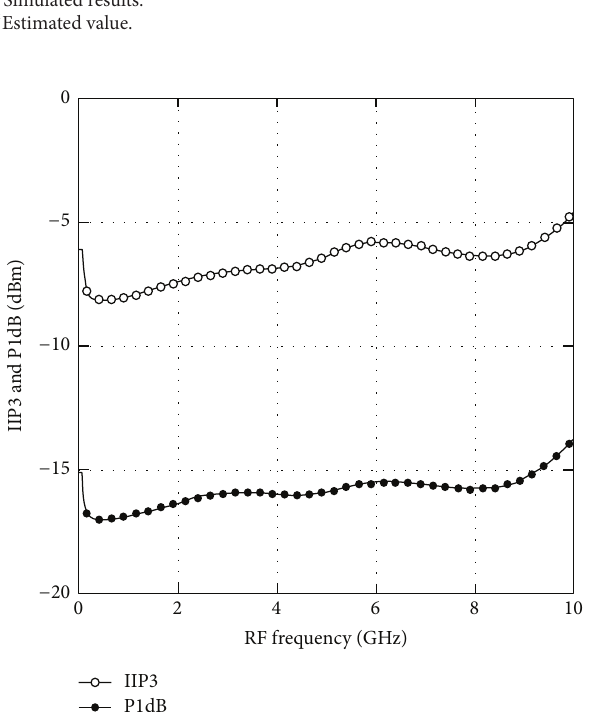
Figure 9: Simulated IIP3 and P1dB versus RF